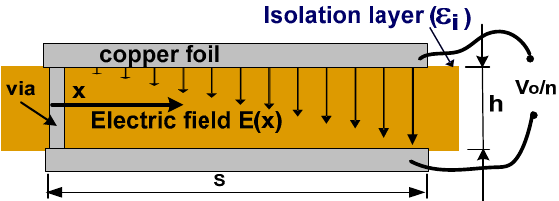
Figure 11. Parasitic capacitance of two conductive layers. Geometrical model of a PCB (printed circuit board).